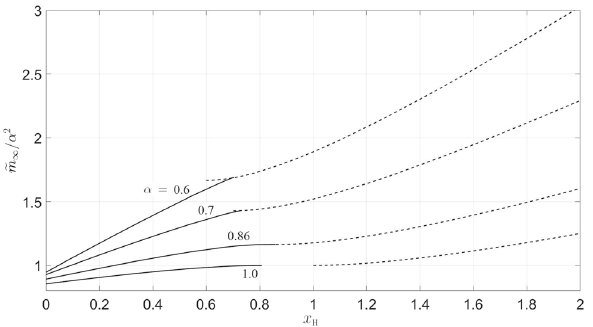
α = 0 . 6 , 0 . 7 , 0 . 86 and H for